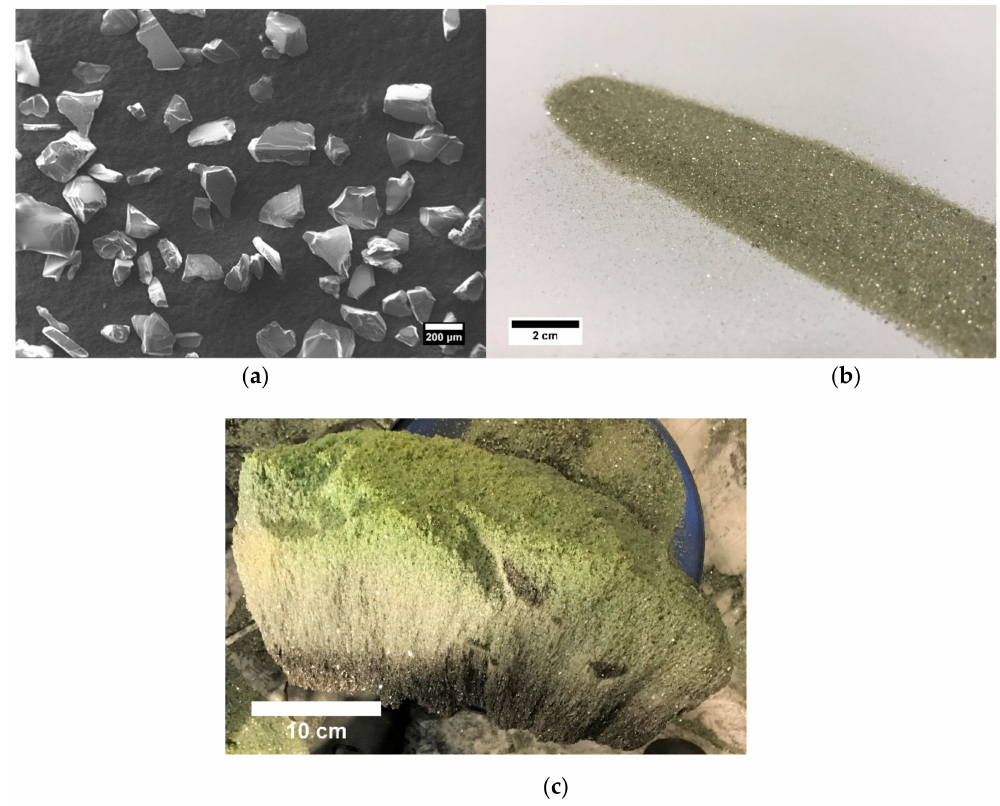
Figure 2. ( a ) SEM image of SiC powder. ( b ) Optical image of the SiC powder source. ( c ) Image of a piece of high purity SiC ingot before processing.